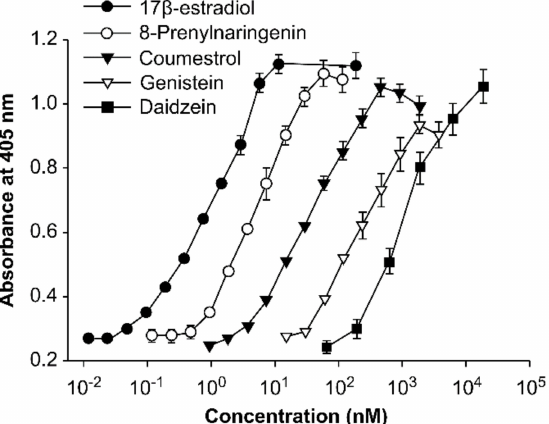
Figure 15. Estrogenic activity of 8–prenylnaringenin and phytoestrogens in human endometrial adenocarcinoma (Ishikawa Var I) cells. Reprinted from Milligan, S.R.; Kalita, J.C.; Heyerick, A.; Rong,